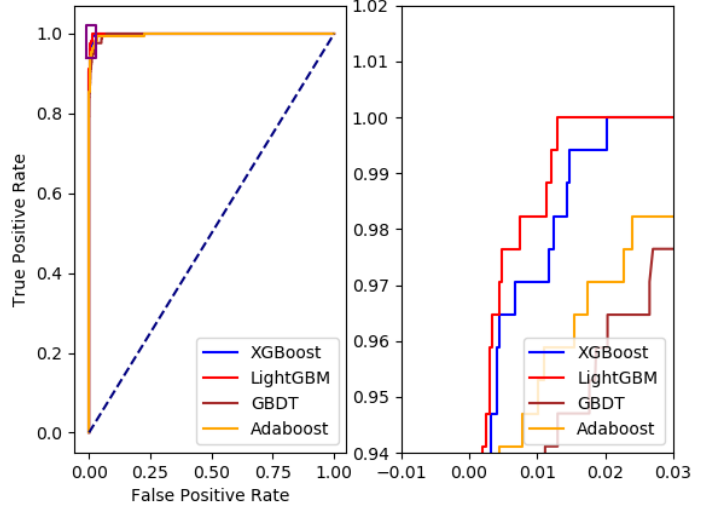
Figure 6. ROC curve of the four models. The left figure shows the ROC of the four models, and the right figure is a partial enlargement of the left figure. In the left figure, the Area Under the Curve represents the AUC and the blue dotted line is a diagonal auxiliary line.